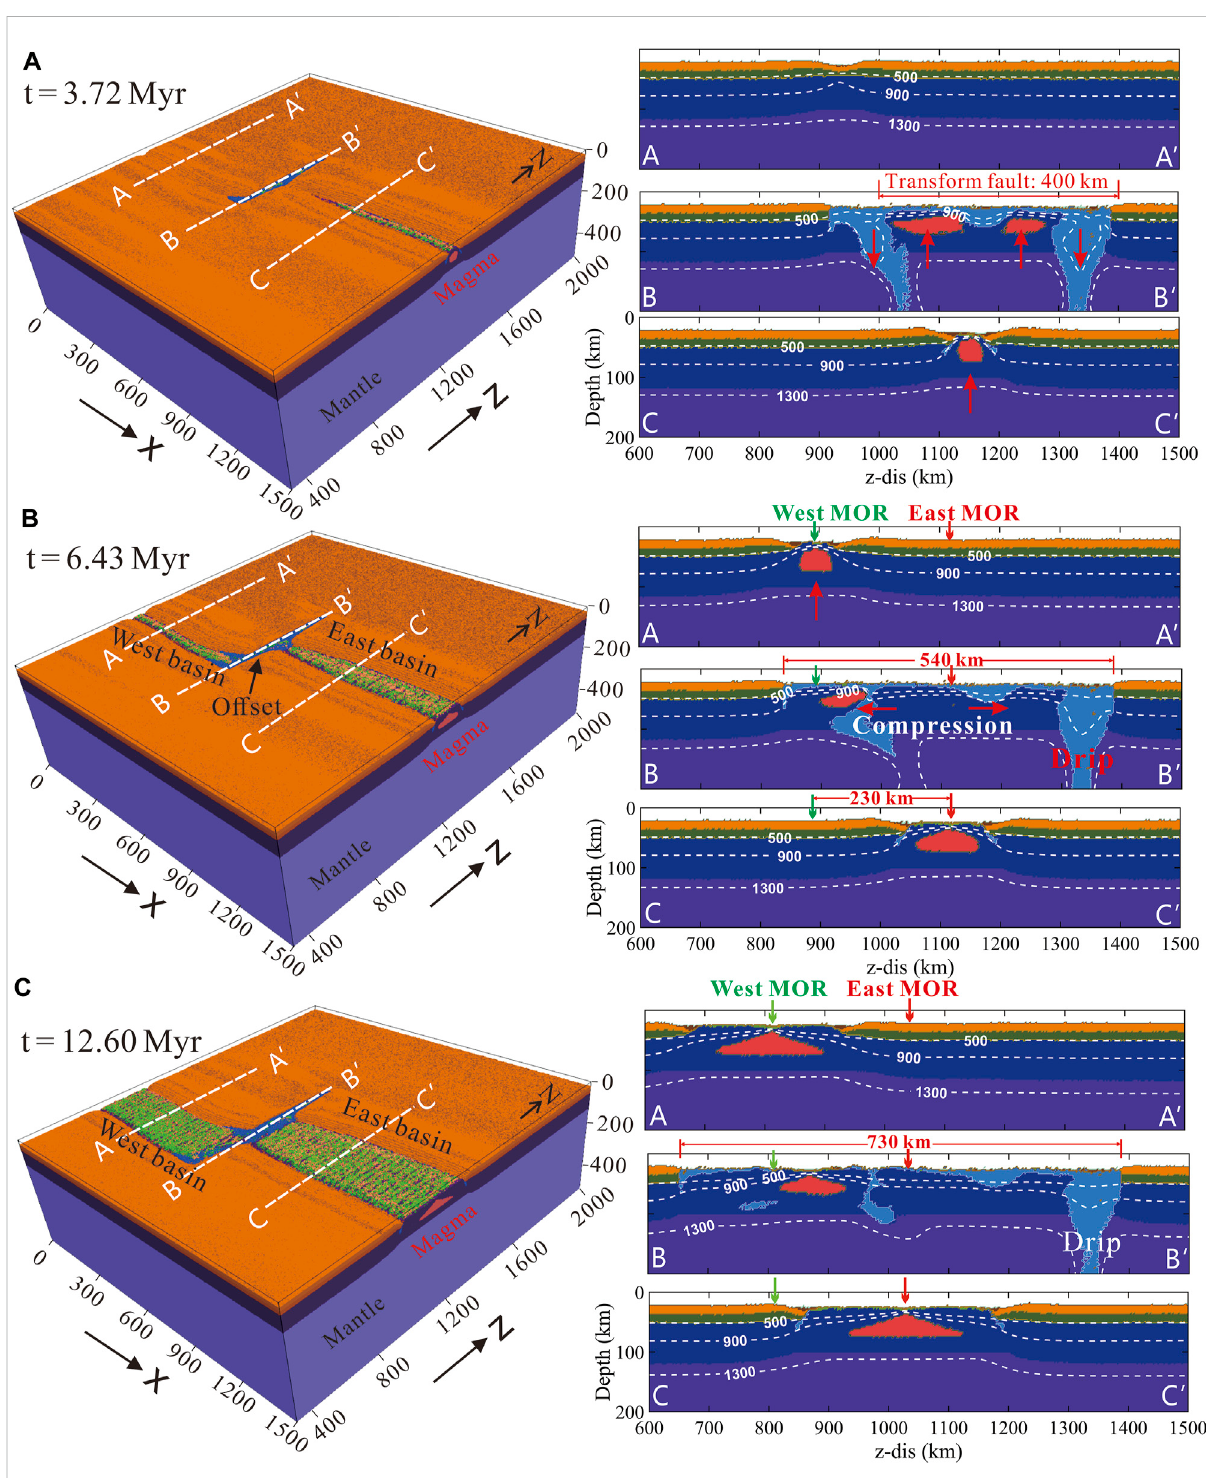
FIGURE 4 Evolution of the reference model shown by lithology snapshots (A – C) Model results at 3.72 Myr, 6.43 Myr, and 12.60 Myr, respectively. Left panels:3Dvisualization.White dashedlinesshow thelocationsofthecrosssectionsdisplayedintherightpanels.Rightpanels: Crosssections.White dashed lines represent the